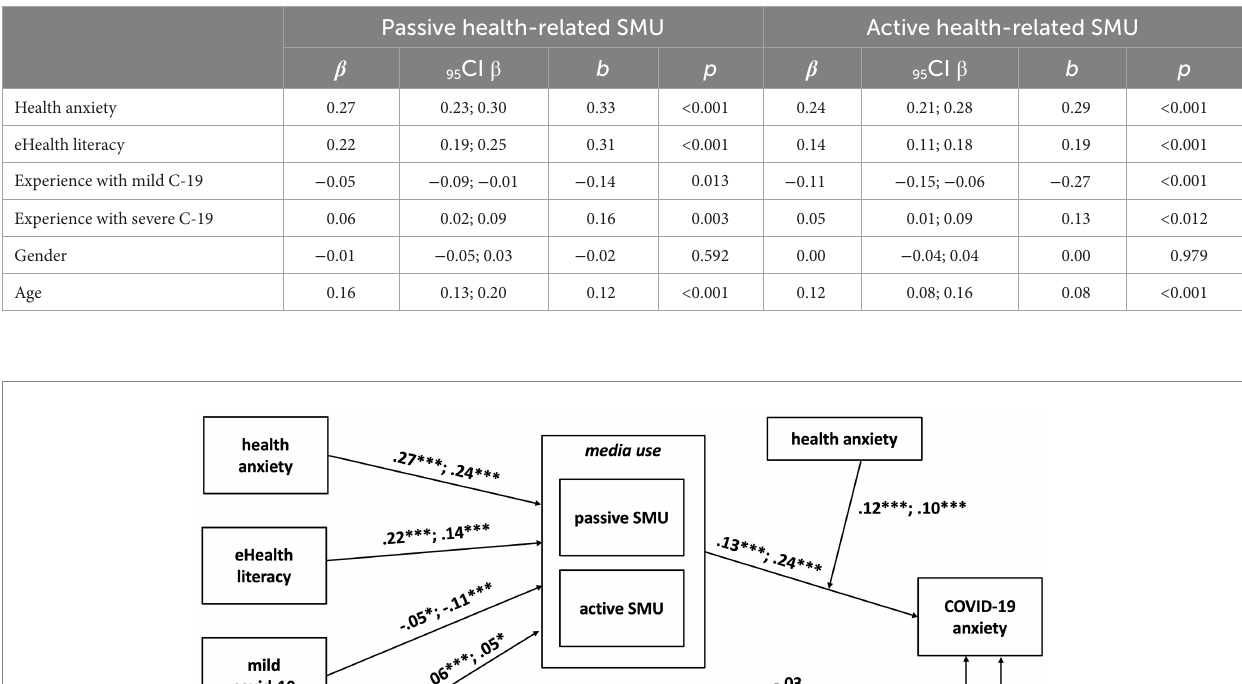
TABLE 3 The results for the main effects on health-related SMU.